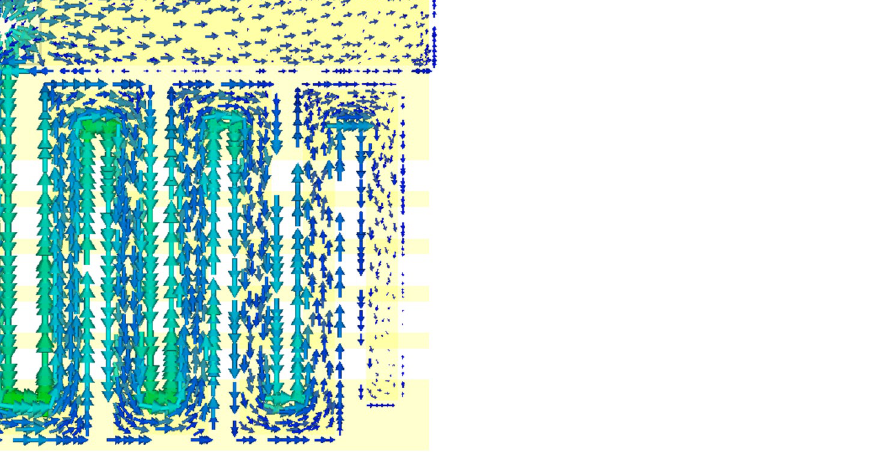
Figure 8. Antenna current distribution diagram (f = 2.45 GHz).